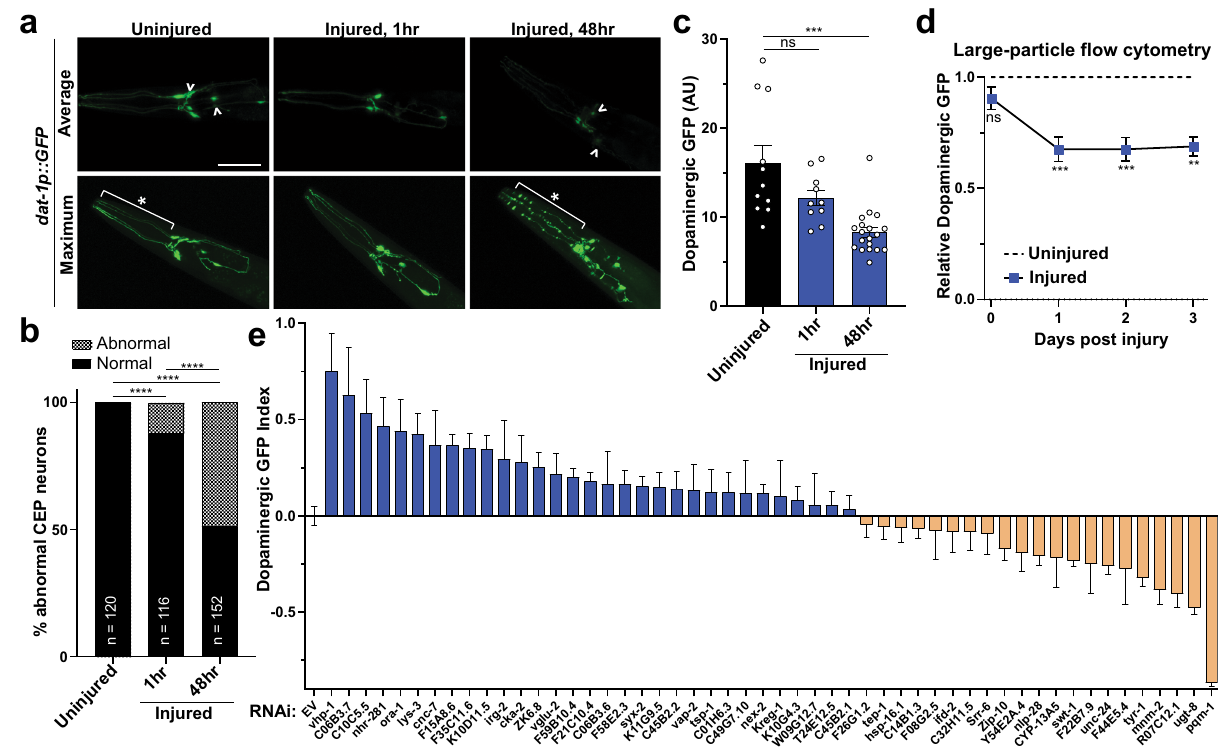
Fig. 3 Reverse genetic screening of stress-responsive genes reveals several modulators of neurodegeneration. a Confocal fl uorescence micrographs of transgenic worms (PMD13) expressing GFP in dopaminergic neurons ( dat-1p::GFP ). Images depict uninjured worms and 1 or 48 h post injury. Upper panels, average-intensity projections of z-stacks show relative brightness. ^ differences in neuronal GFP retention. Lower panels, maximum-intensity projections of Z-stacks show neuron morphology. *Neuronal beading after trauma. Reference Fig. 3b, c. Scale = 50 µ m. b Quanti fi cation of CEP neuronal damage without injury and 1 or 48 h post injury. Neurons with visual beading, dendritic loss, or cell-body loss were scored as abnormal (checkered pattern). **** p < 0.0001 by chi-squared test. n -value represents number of worms examined. c Quanti fi cation of fl uorescence intensity from average projections of CEP neuron z- stacks, uninjured (black) and 1 and 48 h post injury (blue). Mean + SEM, ns (not signi fi cant), and *** p = 0.0003 by one-way ANOVA with Dunnett test. n denotes animals from three independent trials, n = 11 (Uninjured), n = 10 (1 h injury), n = 19 (48 h injury). d Large-particle fl ow-cytometry of worms, expressing GFP in dopaminergic neurons, subject to no injury (---) or paralytic 8600rpm injury (blue square). Fluorescence intensity for each time-point normalized to the uninjured fl uorescence intensity of age-matched controls. Mean± 95% CI. Left to right, *** p = 0.0008 and 0.0007, ** p = 0.0030. Mixed-effects analysis with Bonferonni ’ s multiple comparisons test. See Supplementary Data 5 for additional statistics. e Large-particle fl ow cytometry screening results of dopaminergic neuronal health following RNAi treatment and two days post trauma. X -axis, RNAi gene target or empty vector control (EV). Y -axis, Dopaminergic GFP index indicates relative loss of dat-1p::GFP signal of injured worms from each RNAi condition compared to injured worms grown on EV bacteria. Mean ± 95% CI. Positive values (blue) indicate reduced loss of fl uorescence when compared to age- and RNAi-matched uninjured controls. A value of one indicates no change of fl uorescence compared to uninjured controls. Negative values (tan) represent increased loss of fl uorescence. See Supplementary Data 5 for